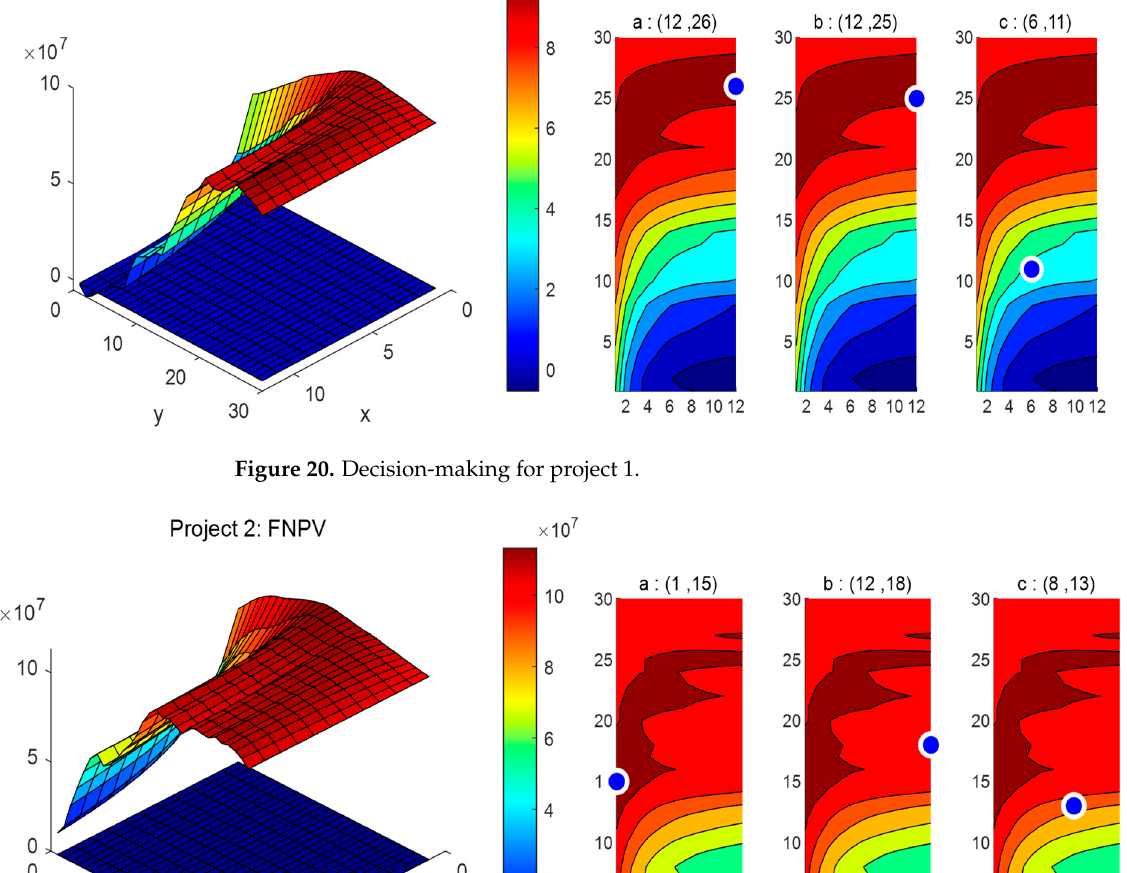
Figure 20. Decision − making for project 1.